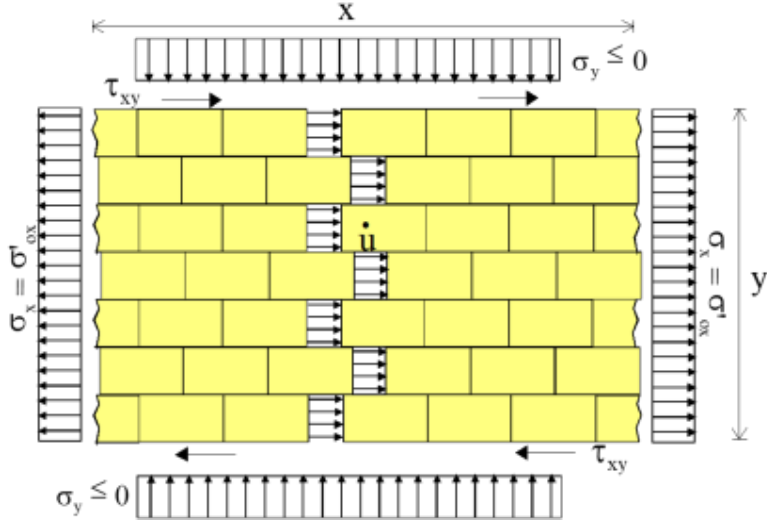
Figure 10 . Stress state and failure mechanisms with activation of fractures. Figure 10. Stress state and failure mechanisms with activation of